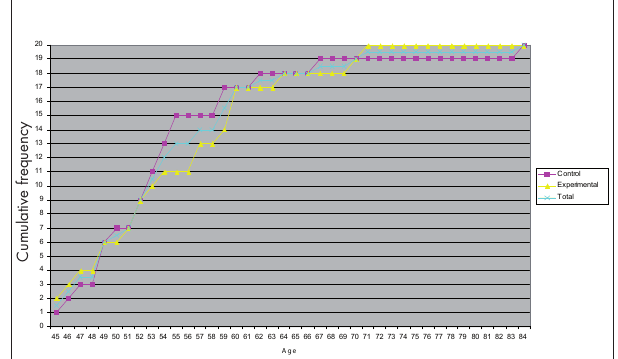
Fig. 1. Cumulative age